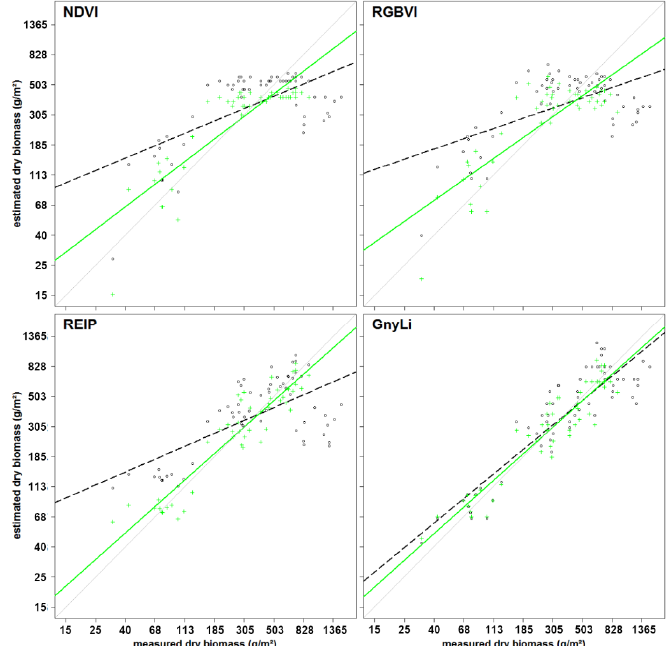
Figure 1. Correction of Figure 5 [1]. Scatterplots of measured vs. estimated dry biomass for one validation data set for NDVI, RGBVI, REIP, and GnyLi (exponential model). Pre-anthesis: crosses and solid green line; whole observed period: circles and dashed black line; 1:1 line: light grey.